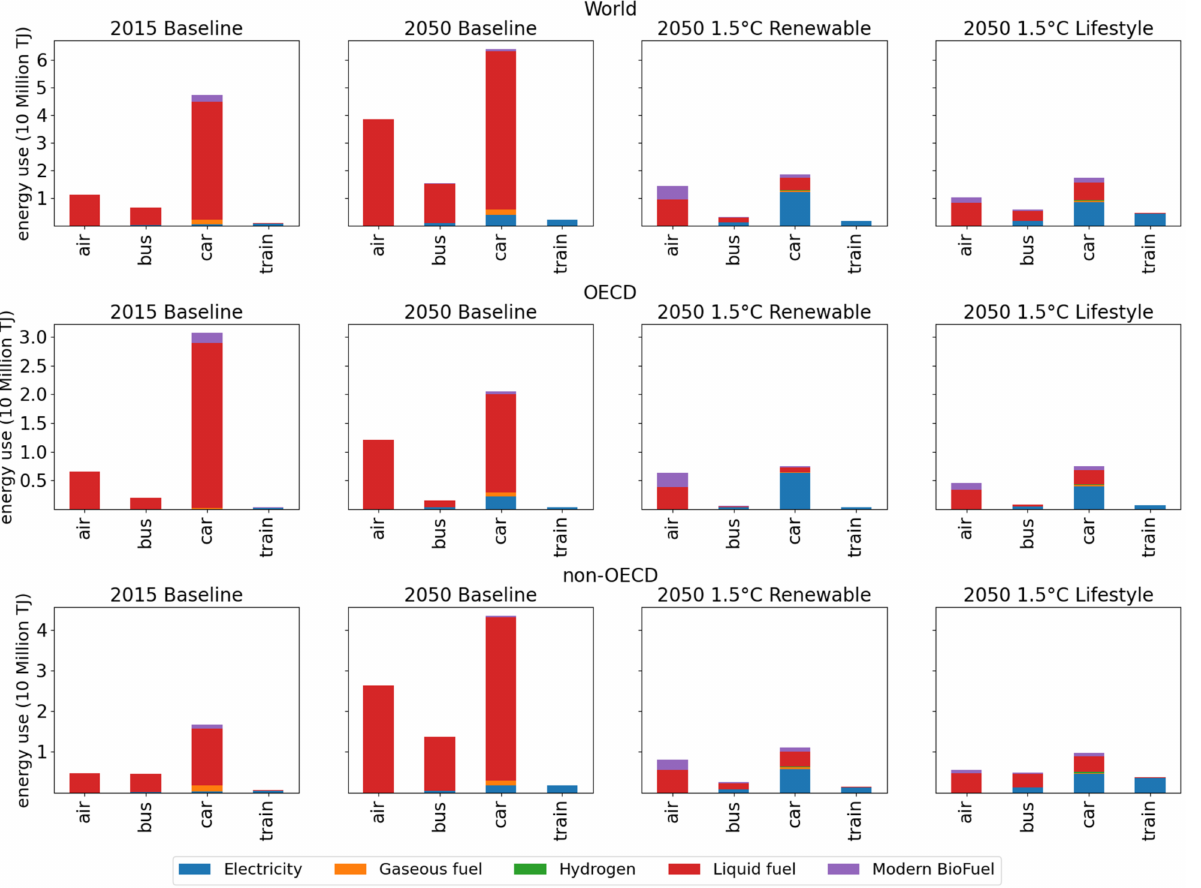
Figure 7. Energy mix by passenger travel